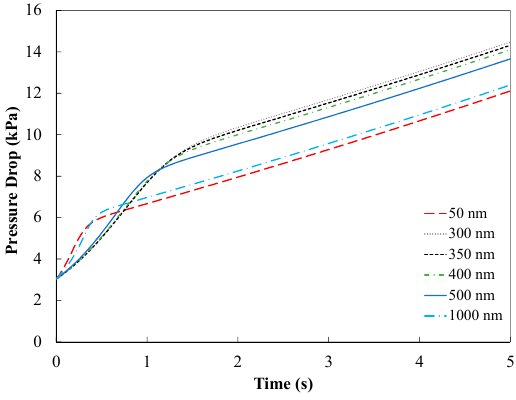
Figure 12 highlights the influence of soot particle diameter on pressure drop evolution with time.